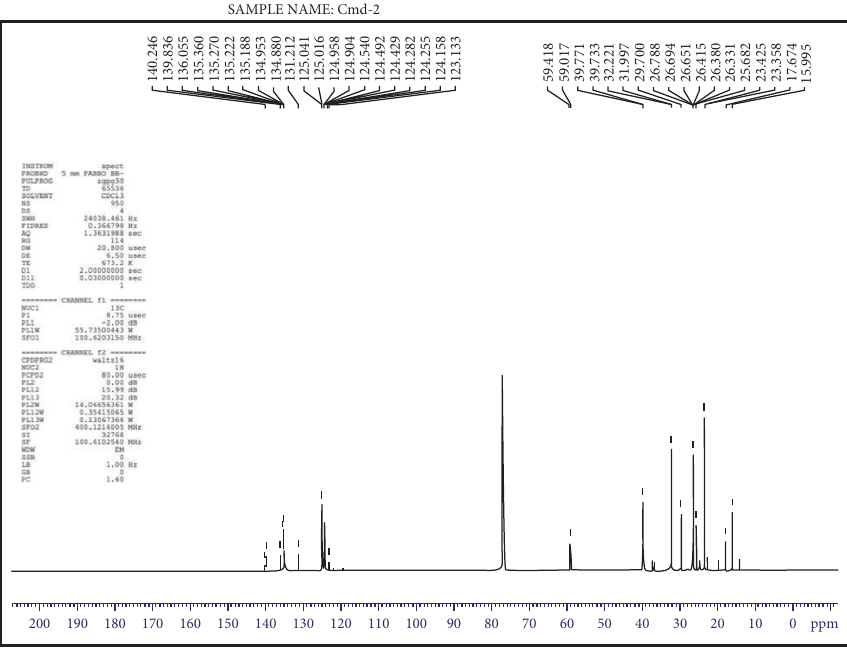
Figure 2: 13 C NMR spectrum analysis for compound